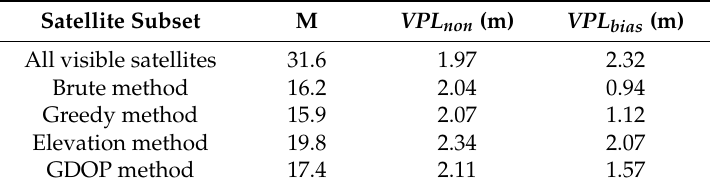
Table 4. The average satellite number M, VPL non and VPL bias of different satellite subsets. Satellite Subset